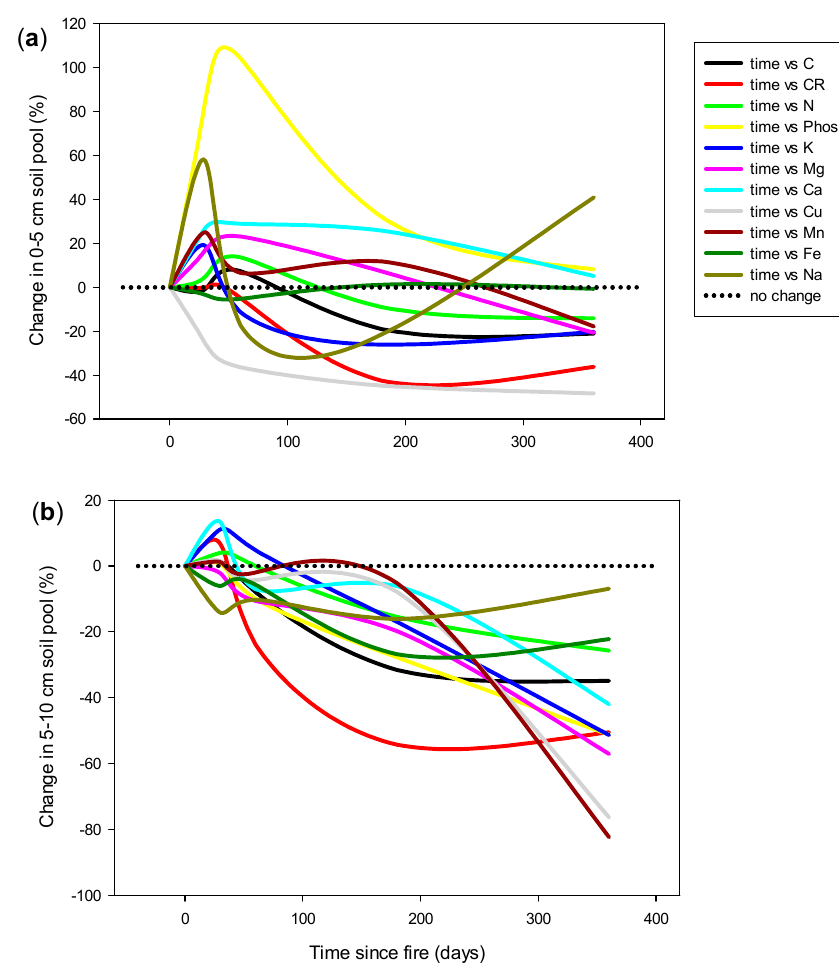
Figure 7. Percent change in soil C, C R , N, macro and micronutrients from samples collected pre-burn and 1, 3, 6, and 12 months after the fire at depths of 0–5 ( a ) and 5–10 cm ( b ).